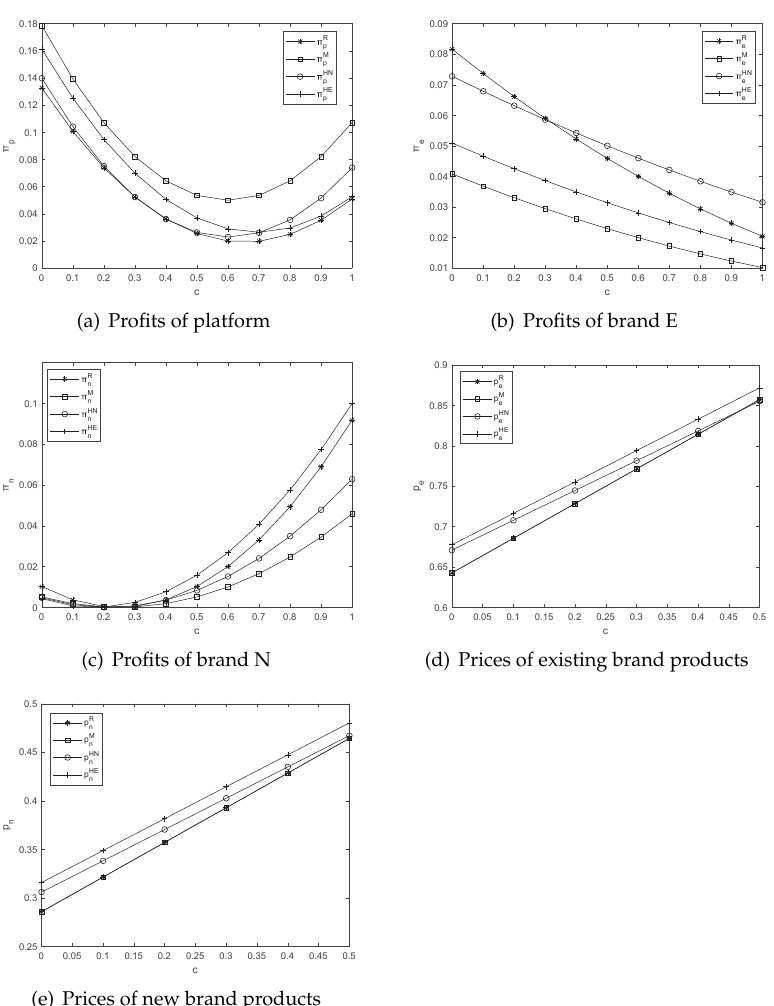
Figure 5. The impacts of parameter c on the equilibrium